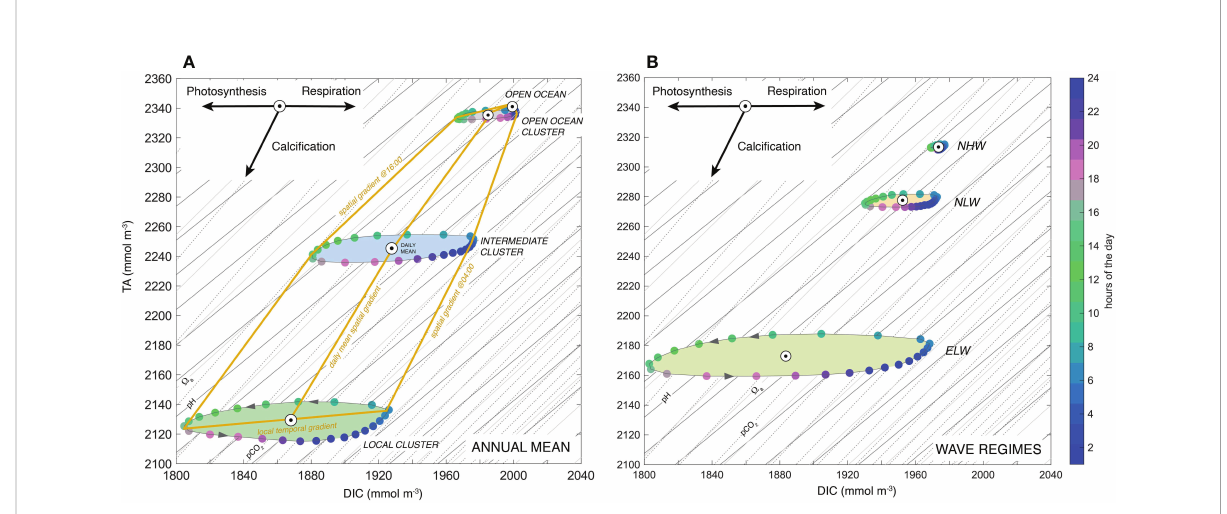
FIGURE 10 Processes determining the diel cycle of seawater chemistry: Variations of TA versus DIC across the reef system for the annual mean (A) and for the whole reef and for the different wave regimes (B) . Shown are the diel progression in each of the three biogeochemical niche clusters. Colors indicate the hours of the day. Shown are also the isolines for pH (dark-grey line), p CO 2 (grey line) and Ω a (dashed line). The arrows at the top left indicate how the processes of photosynthesis/respiration and calci fi cation change seawater